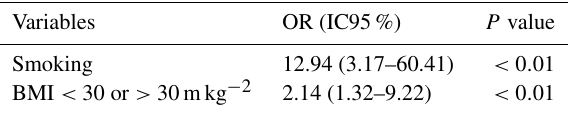
Table 7. Multivariate analysis of risk factors for